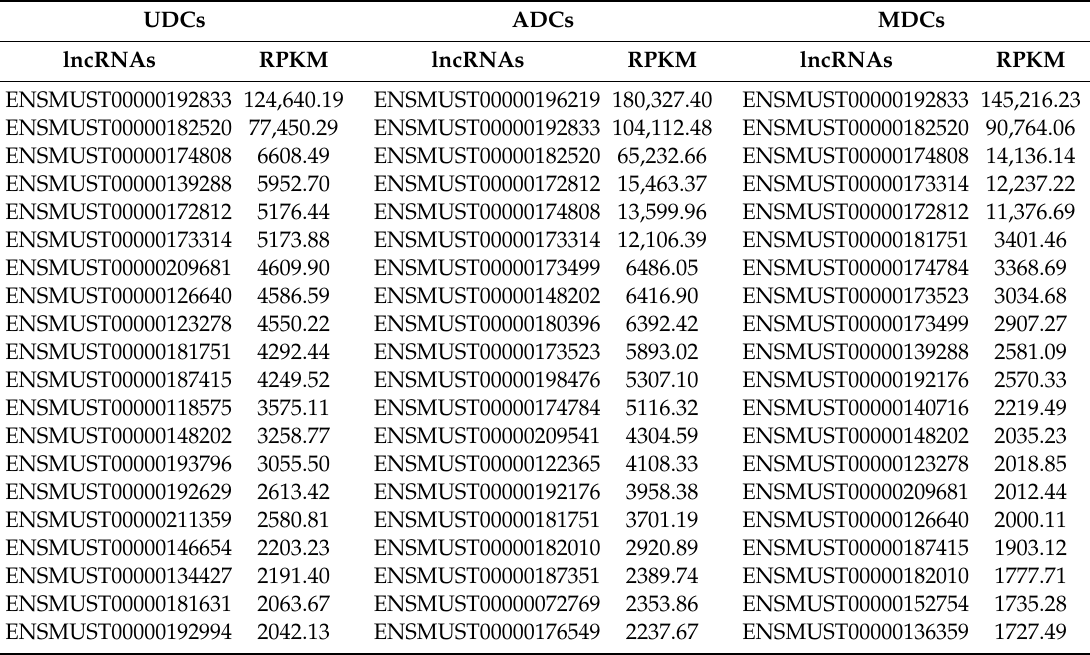
Table 1. The top expressed 20 lncRNA transcripts in the UDCs, MDCs, and